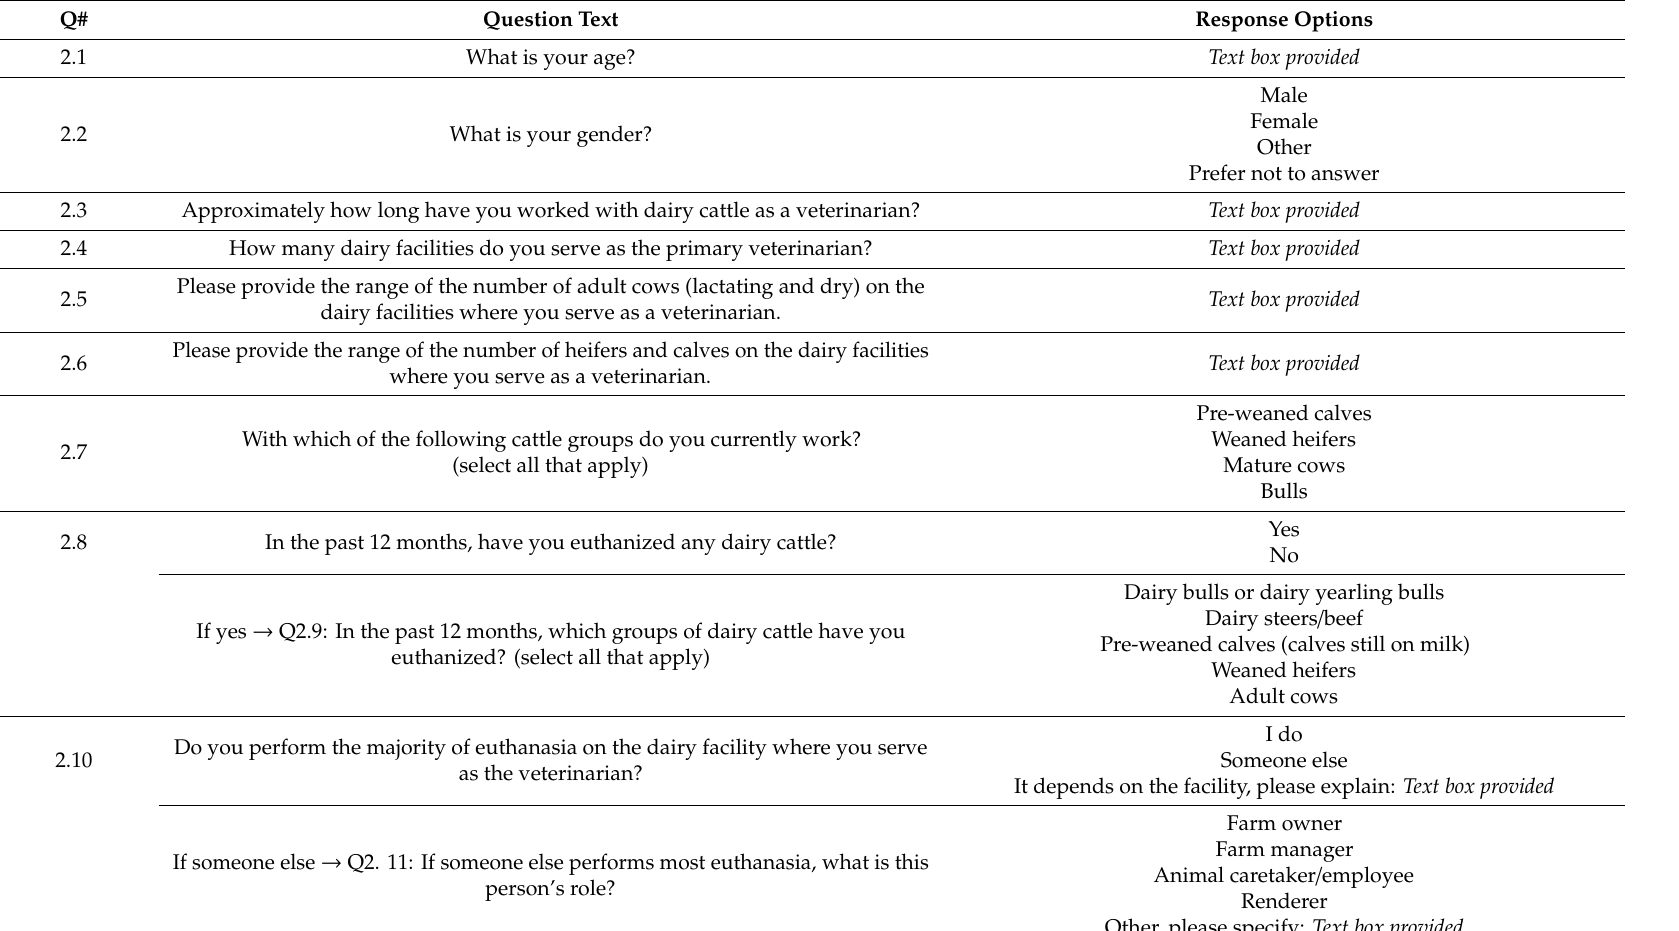
Table A1. Survey questions used to attain respondent demographic information, including the response options provided for each